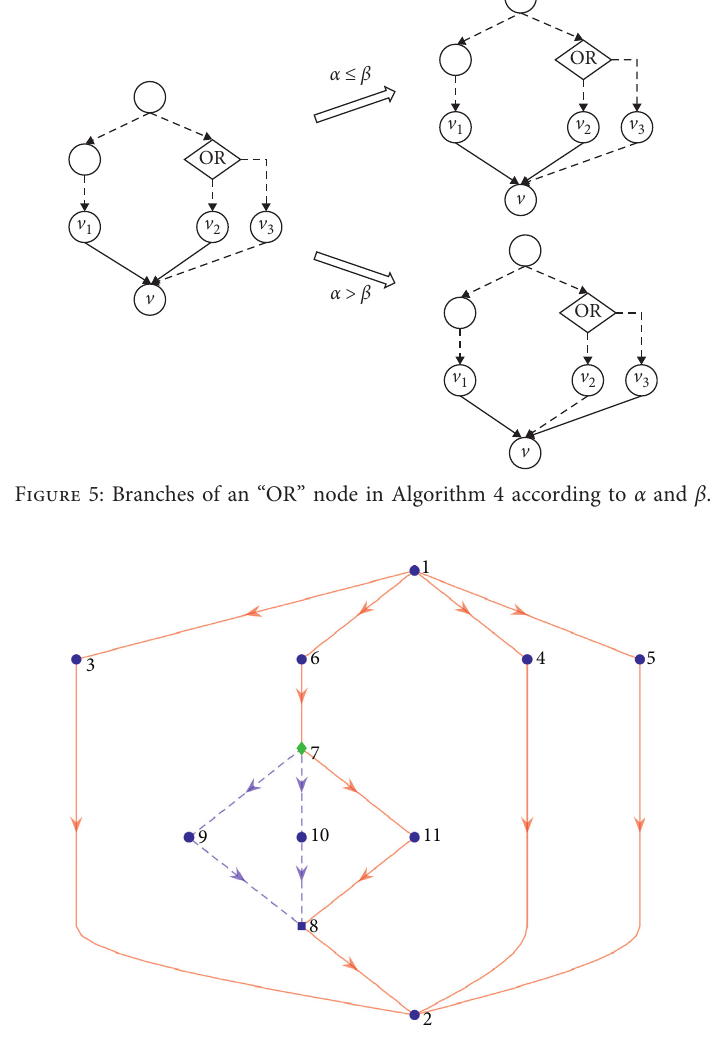
Figure 6: AND/OR network of the D&A operations for the diesel